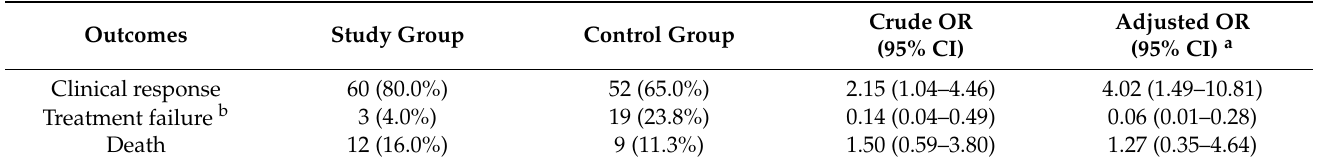
Table 2. Associations between the dosage of cefoperazone-sulbactam and clinical outcomes.